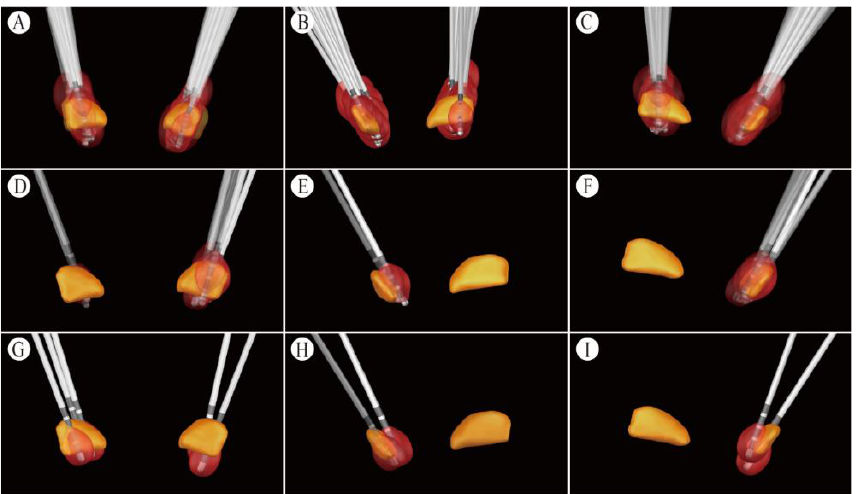
Figure 2. Overlapping of VTA contact activation area and the STN (including frontal, left, and right lateral views, respectively). ( A – C ) VTA contact activation area covered by the STN nucleus in 33 patients. The VTA covered the sensorimotor and associative parts of the STN, as well as the zona incerta (ZI). ( D – F ) In 9 patients with recurrent RLS, after program-controlled adjustment of stimulation parameters, RLS symptoms were significantly improved, while PD motor symptom scores did not change significantly. The VTA contact activation area at this point primarily covers the central sensorimotor area medial to the STN. ( G – I ) Activation of the lowermost VTA contact area induced RLS symptoms in 5 patients. The area overlapped with the lower border of the STN, and the common activation area is close to the substantia nigra.